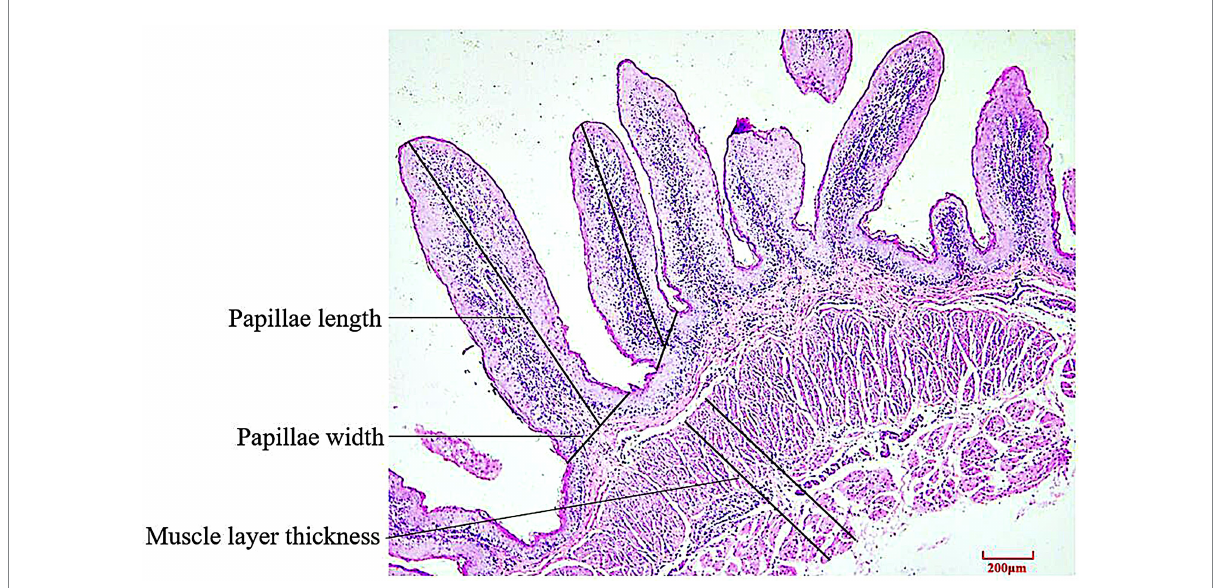
FIGURE 1 Schematic diagram of histological sections and determination of rumen tissue (HE